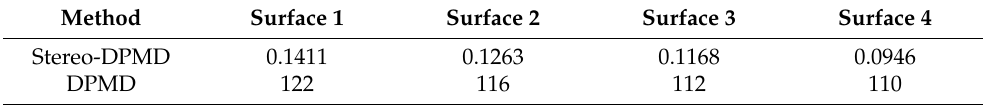
Table 3. The RMS values between fitted surfaces and measured surfaces (units: µ